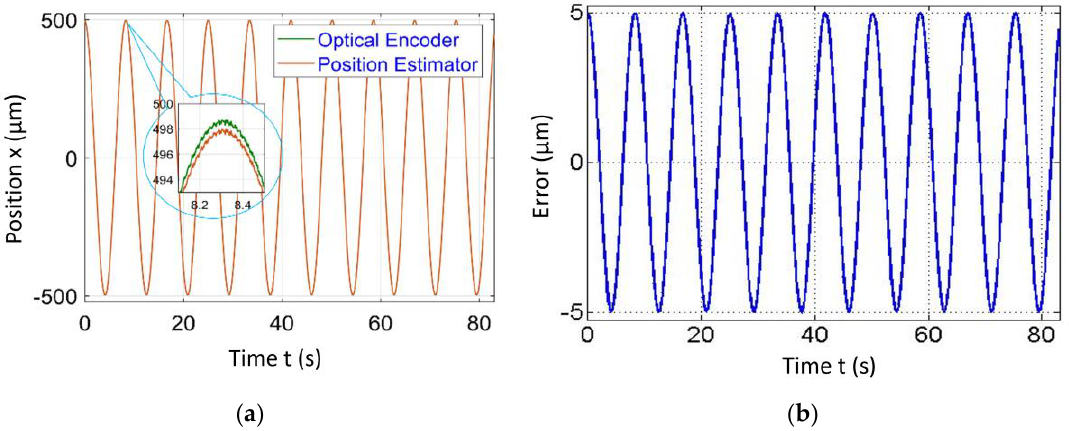
Figure 16. Position estimator output for amplitude = 500 µm and frequency = 0.75 Hz at a scanning speed = 1.5 mm / s. Sensors 2020 , 20 , 662